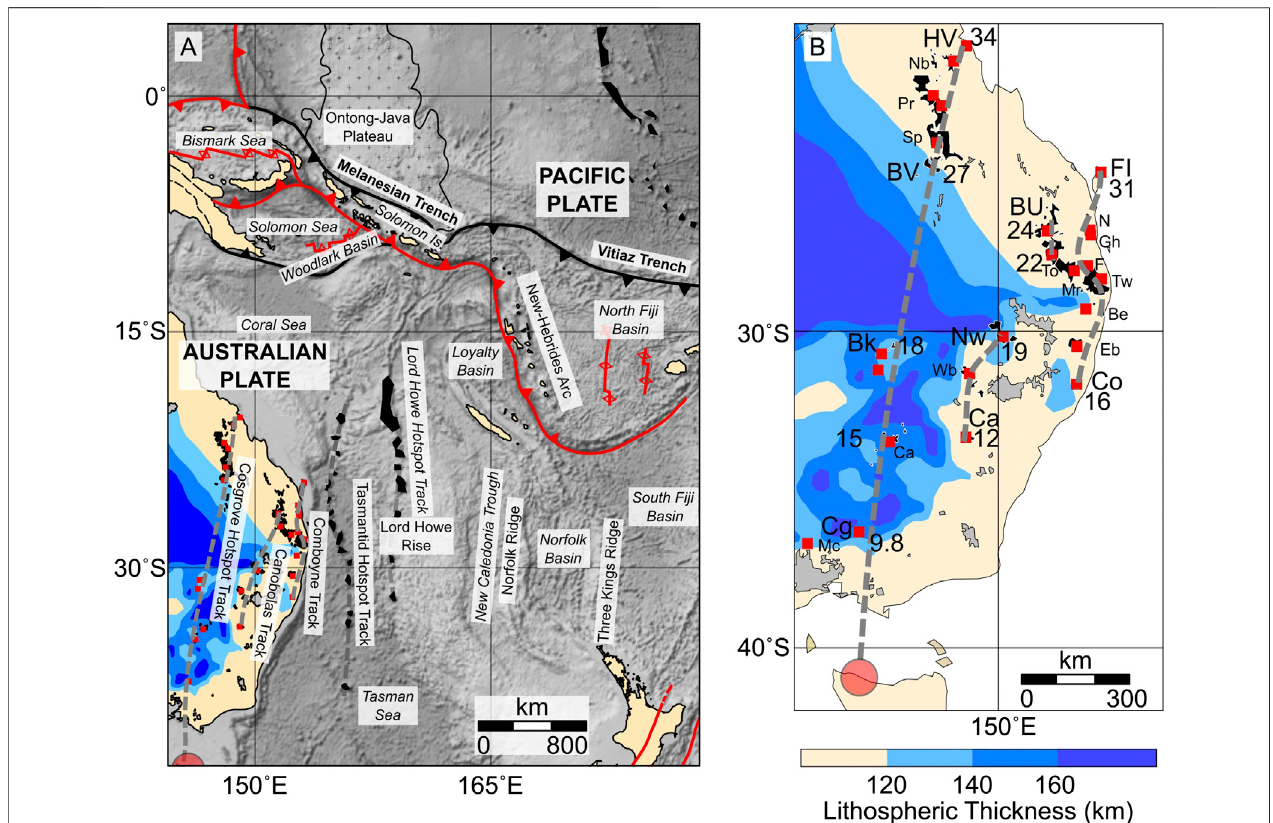
FIGURE1| DistributionofeasternAustralianCenozoicVolcanism,hotspottracksandlithosphericthickness.Centralvolcanic fi eldsareindicatedinblack,lava fi eld provincesingray(WellmanandMcDougall,1974).Hotspot tracksareindicatedbydashed graylines,withages(inMa)indicated(Cohenetal.,2007;Cohenetal.,2008; Knesel et al., 2008; Sutherland et al., 2012; Cohen et al., 2013). The red circle indicates a 100 km diameter melt region for the Cosgrove hotspot above its present day position as inferred from tomography (Montelli et al., 2006). HV, Hillsborough Volcano; Nb, Nebo Volcano; Pr, Peak Ranges (North and South); Sp, Springsure Volcano; BV, Buckland Volcano; Bk, Byrock Leucitite; Ca, Cargelligo; Cg, Cosgrove Leucitite; Mc, Macedon; FI, Fraser Island; N, Noosa; Gh, Glasshouses; F, Flinders Volcano; Tw, Tweed Volcano; BU, Bunya Volcano; To, Toowoomba Volcano; Mr, Main Range; Be, Belmore Volcano; Eb, Ebor Volcano; Nw, Nandewar Volcano; Wb, Warrumbungle Volcano; Ca, Canobolas Volcano; Co, Comboyne Volcano.